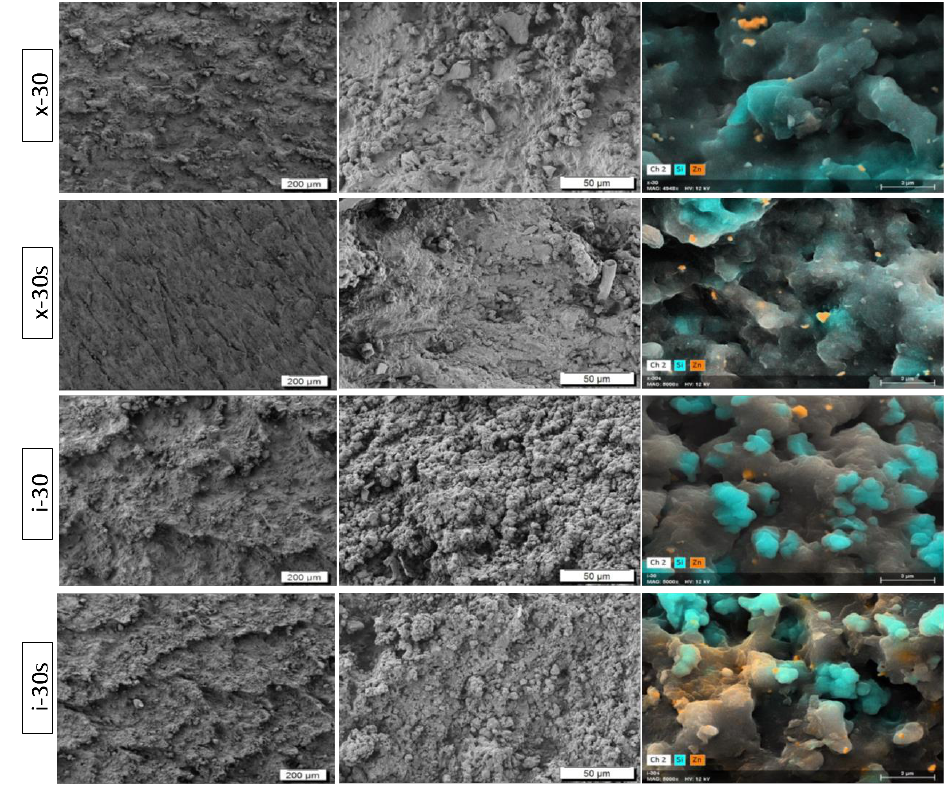
Figure 7. SEM and EDX images of abraded surfaces (after the DIN abrasion test) of 30 phr precipitated silica, in-situ silica, and their TESPT modified SSBR composites.